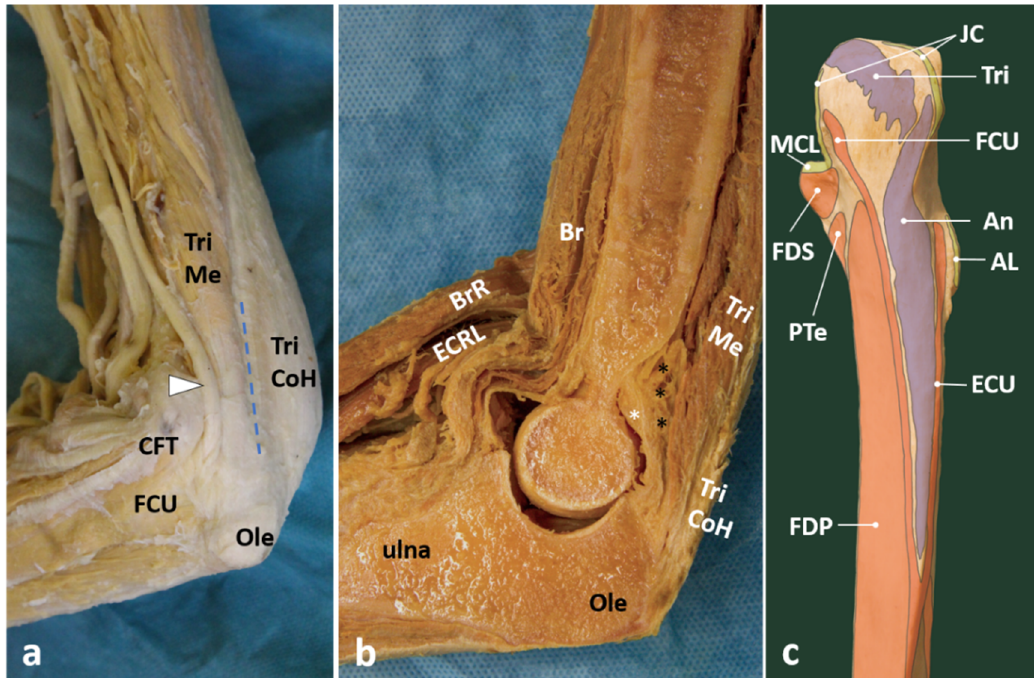
Figure 11. The tricipital tendon (right elbow). ( a ) The tricipital tendon is attached to the olecranon. The tendon has a bipartite arrangement. The medial head has separate insertion from the common tendon of lateral and long heads. The dashed line indicates the border between them. ( b ) Attachment of the common and medial heads on the sagittal section. The medial head’s insertion is more muscular and more profound than the common head insertion. ( c ) Location of muscular and ligamentous attachments on proximal ulna from the posterior aspect. Black asterisks: distal pretricipital space filled with fat and connective tissue, white asterisk: the posterior fat pad inside the joint, white arrowhead: ulnar nerve, AL: annular ligament, An: anconeus muscle, Br: brachialis muscle, BrR: brachioradialis muscle, CFT: common flexor tendon, ECRL: extensor carpi radialis longus muscle, ECRB: extensor carpi radialis brevis muscle, EDig: extensor digitorum muscle, ECU: extensor carpi ulnaris muscle, FCU: flexor carpi ulnaris muscle, FDS: flexor digitorum superficialis muscle, FDP: flexor digitorum profundus muscle, JC: joint capsule, ME: medial epicondyle, Ole: olecranon, Pte: pronator teres TriMe: triceps brachii—medial head, Tri–CoH: triceps brachii–common head (lateral and long